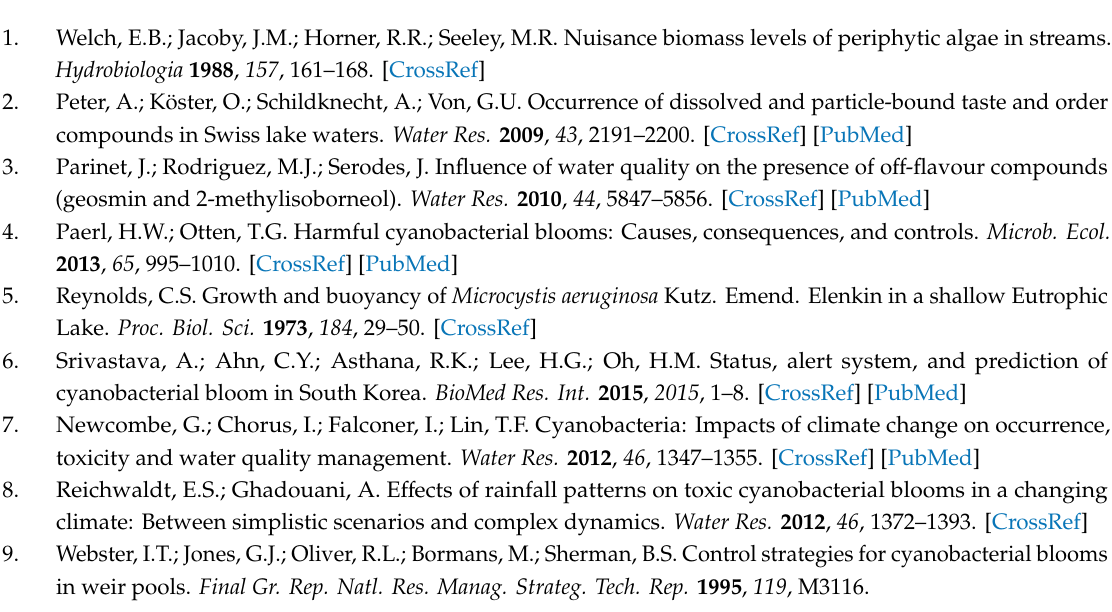
Figure S1—Partial dependence plots of random forest (RF) models, showing marginal e ff ects of single variables on cyanobacterial dominance (C.dominance) at; (a) Gangjeong Goryeong weir (GGW), (b) Dalseong weir (DSW), (c) Hapcheon Changnyeong weir (HCW), and (d) Changnyeong Haman weir (CHW). Note: see the main document for definitions of variables. Table S1—Bi-variable correlation analysis between parameters relevant to cyanobacterial estimation at the Gangjeong Goryeong weir (GGW; right, gray) and the Dalseong weir (DSW; left, white). Note: see the main document for definitions. Table S2—Bi-variable correlation analysis between parameters relevant to cyanobacterial estimation at Hapcheon Changnyeong weir (HCW) (right, gray), and Changnyeong Haman weir (CHW) (left, white). Note: see the main document for definitions. Table S3—Correlation analysis between nutrients (total phosphorous, TP; and total nitrogen, TN) and chlorophyll–a (Chl–a) at the Gangjeong Goryeong weir (GGW), the Dalseong weir (DSW), the Hapcheon Changnyeong weir (HCW), and the Changnyeong Haman weir